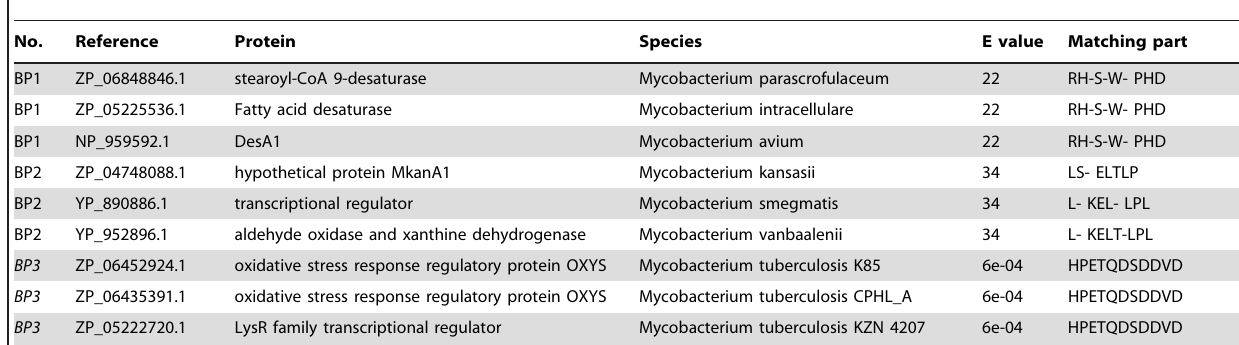
Table 3. Blast Analysis of BP1, BP2 and